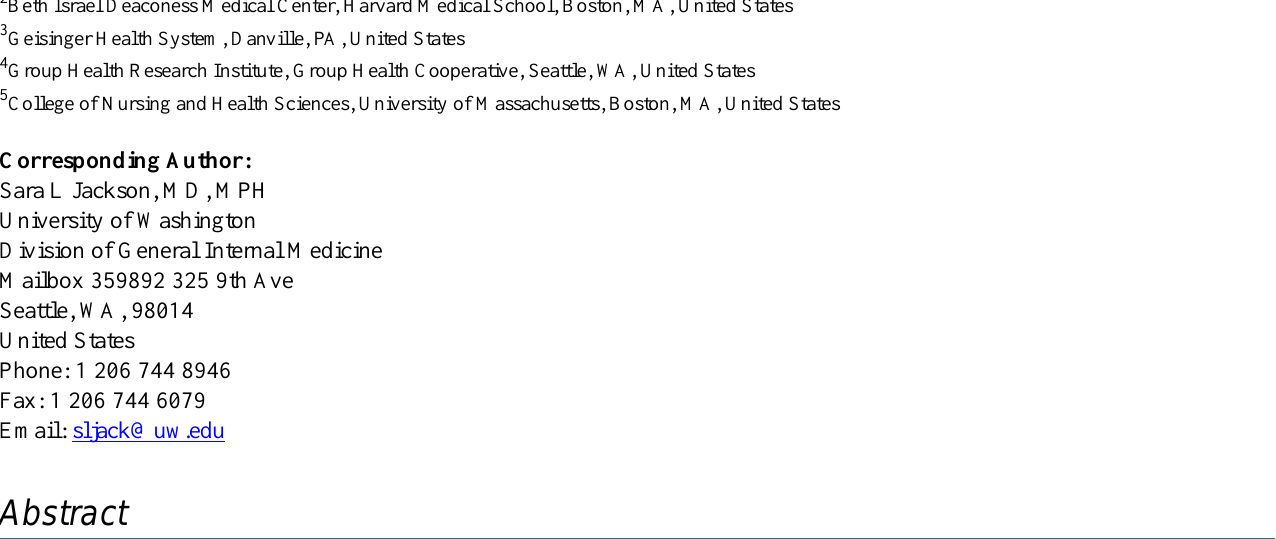
open access to information; caregivers; health behavior; information